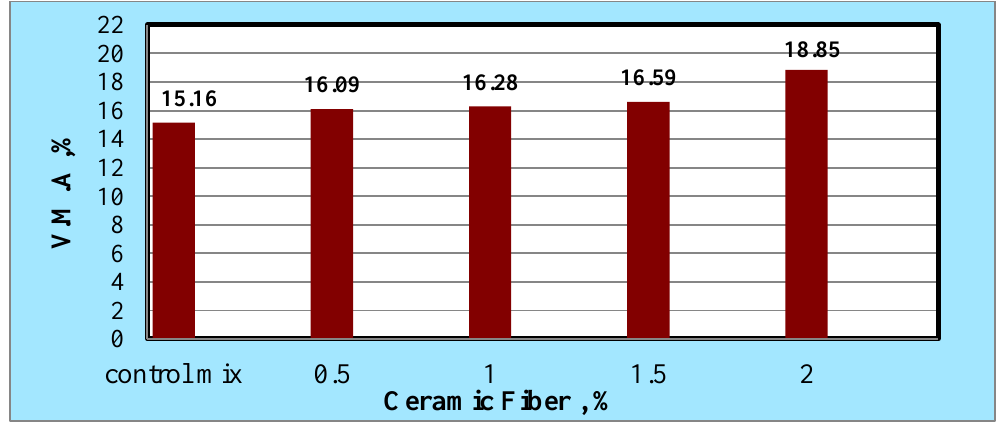
Fig. 6. Effect of Ceramic Fiber on V.M.A of Asphalt